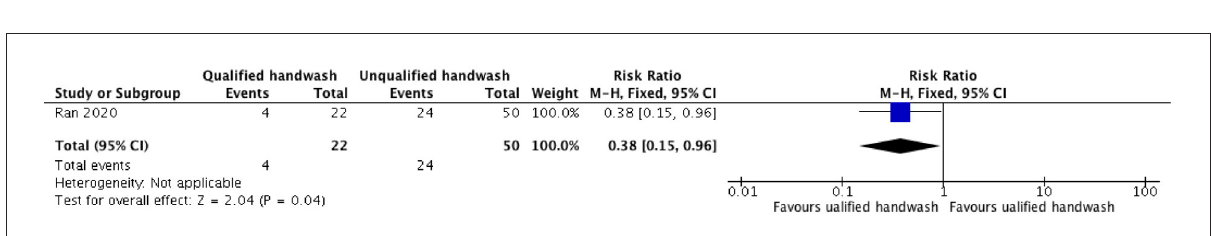
FIGURE3 Forest plot showing effect of qualified handwash as compared to unqualified handwash on the number of COVID-19 cases.